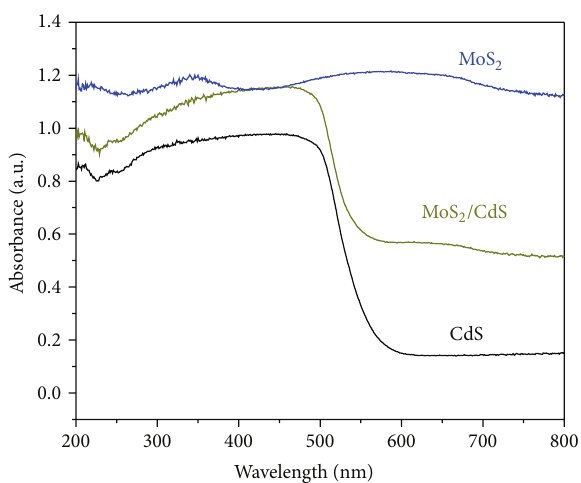
Figure 4: DRS of MoS 2 , CdS, and MoS 2 /CdS.